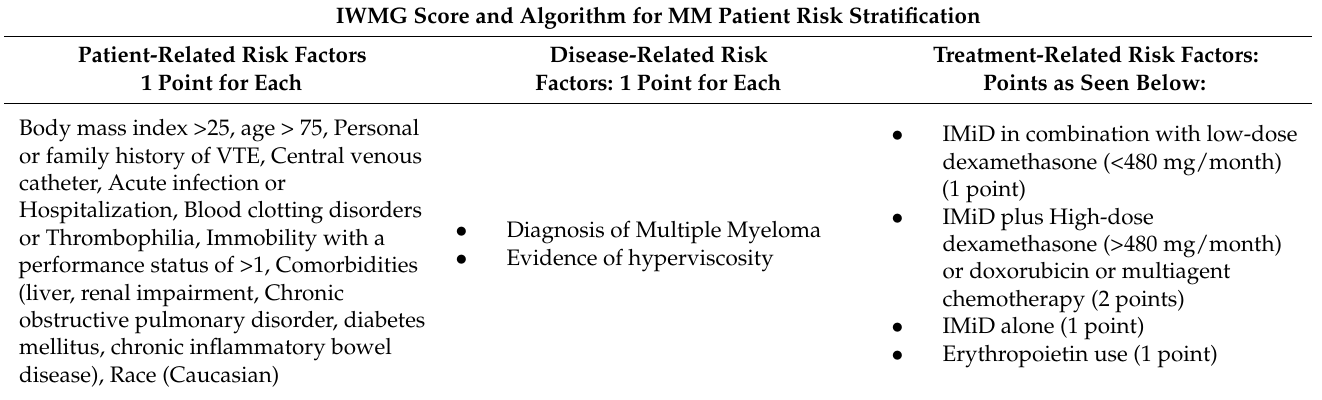
Table 2. (a) IWMG score and algorithm for MM patient risk stratification. (b) IMPEDE and SAVED risk assessment